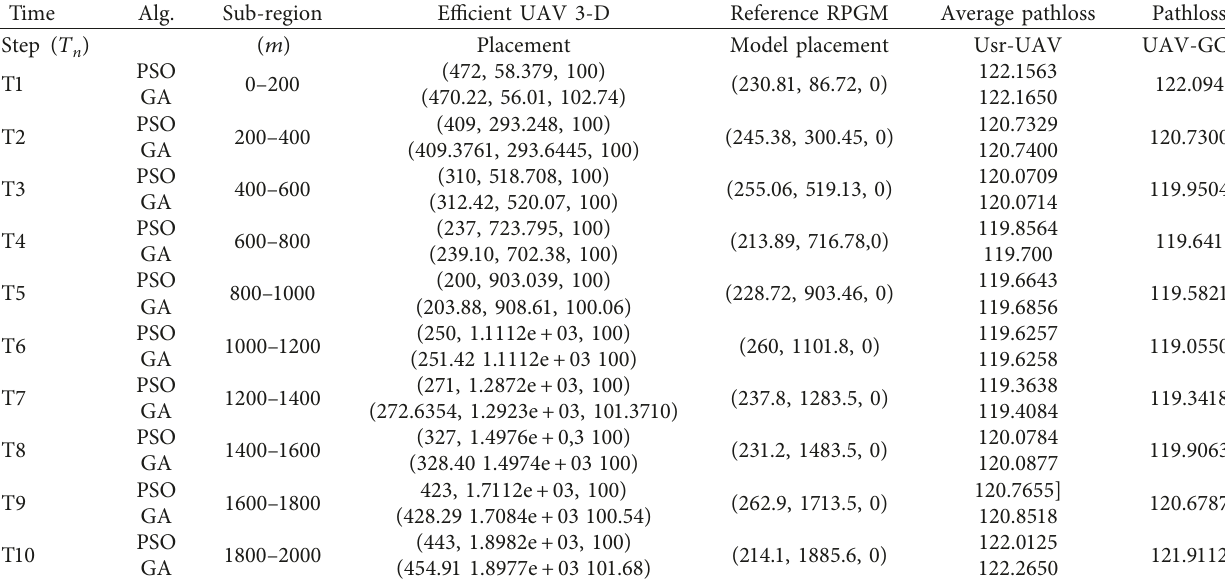
Table 2: Simulation results for mining mission inside a